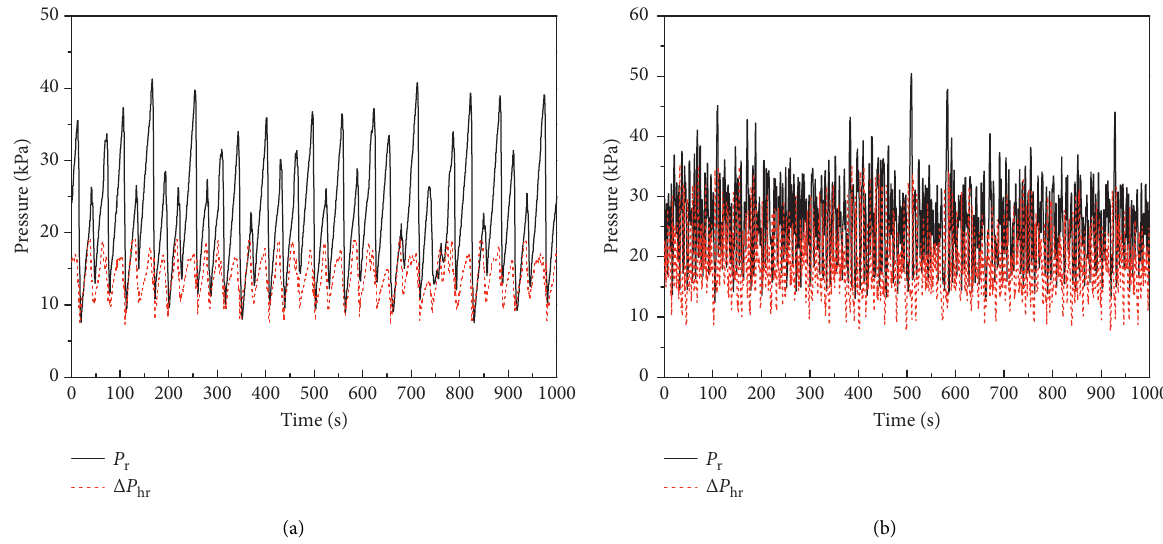
Figure 8: Pressure of P r and Δ P hr for low-frequency oscillation flow (a) and high-frequency oscillation flow (b).